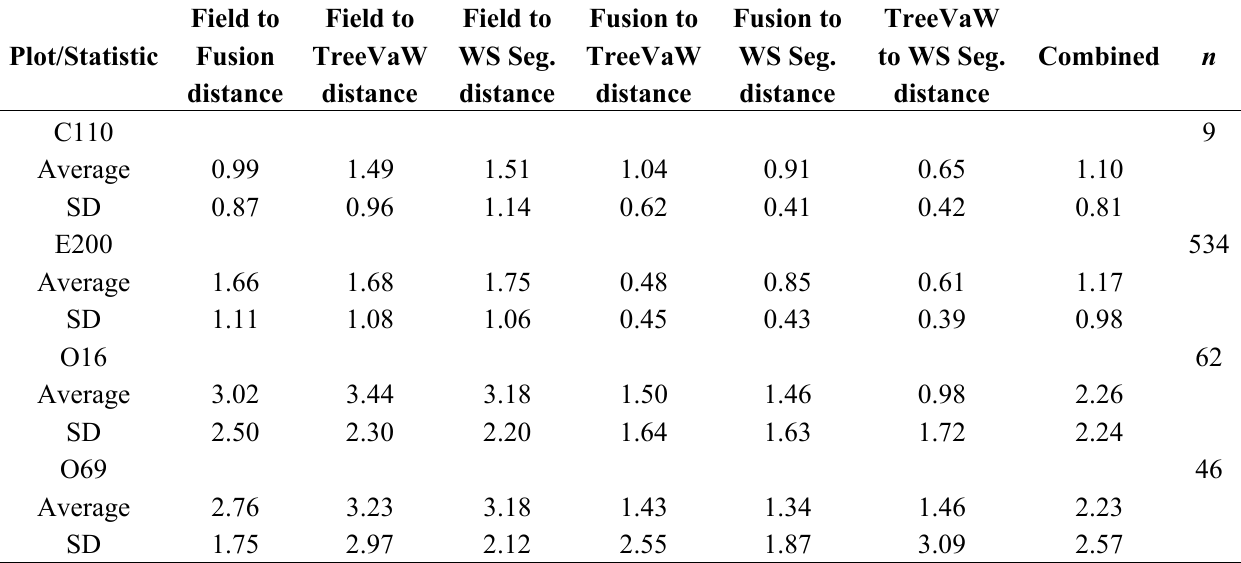
Table 13. Comparison of horizontal distance (m) between trees determined to be the same feature. Selection criterion was that the tree was delineated in all four methods (field, FUSION, TreeVaW and watershed